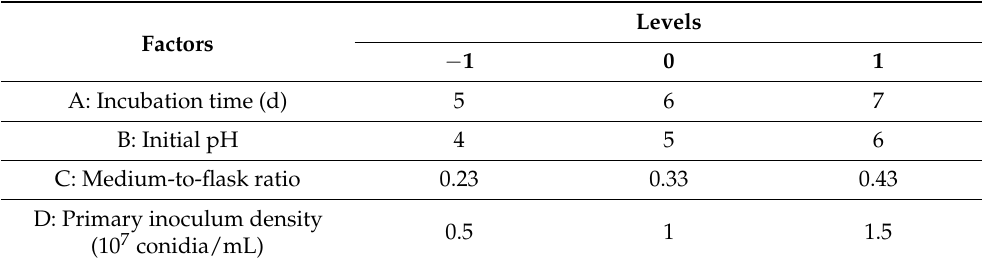
Table 2. The levels and code of variable chosen for